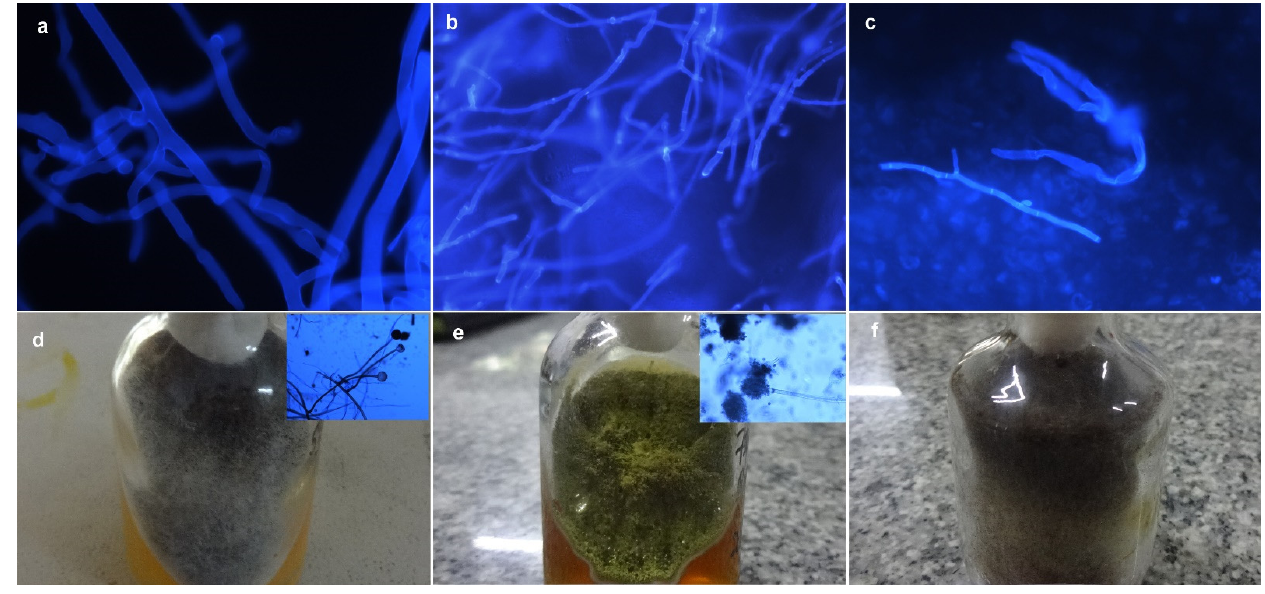
Figure 3. ( a ): KOH + CFW mount showing broad, aseptate fungal hyphae; ( b ): KOH + CFW mount showing narrow and septate fungal hyphae. ( c ): KOH + CFW mount showing both broad, aseptate and narrow, septate fungal hyphae in one sample. ( d ): Black, cottony fungus grown on SDA medium and Lactophenol cotton blue mount showing sporangia and rhizoides. ( e ): Yellowish green Fungus grown on SDA medium and Lactophenol cotton blue mount showing rounded onidial heads. ( f ): Both black, cottony fungus and yellow-green fungus in the same SDA medium. Table 2. Diagnostic performance of various tests in detecting fungal pathogens in clinical samples of ROCM